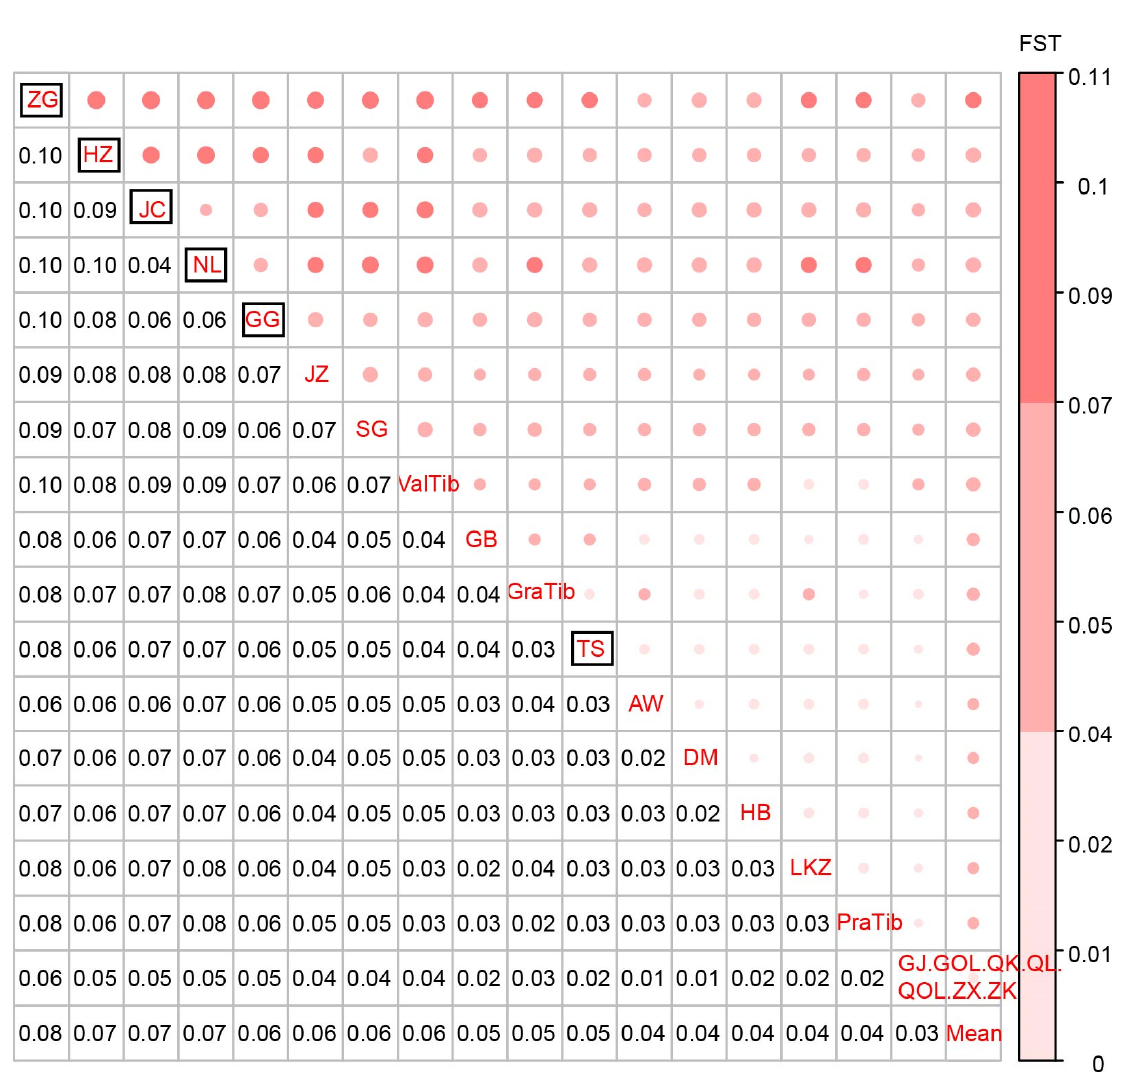
Figure 3. Population genetic differentiation distance (FST) between two Tibetan sheep populations. The values in the bottom-left represent population divergence (FST) between each of the two populations. The populations in the black boxes show medium population differentiation levels in five Tibetan regions, respectively.